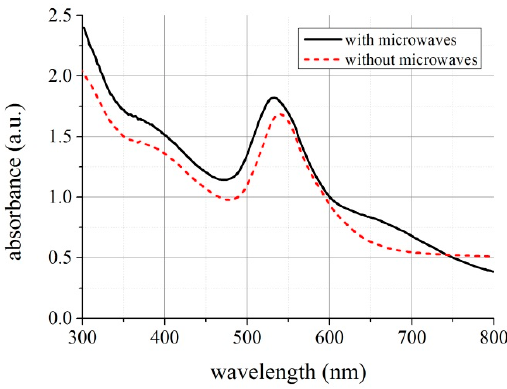
Figure 12. Absorbance of samples with and without microwave treatment.